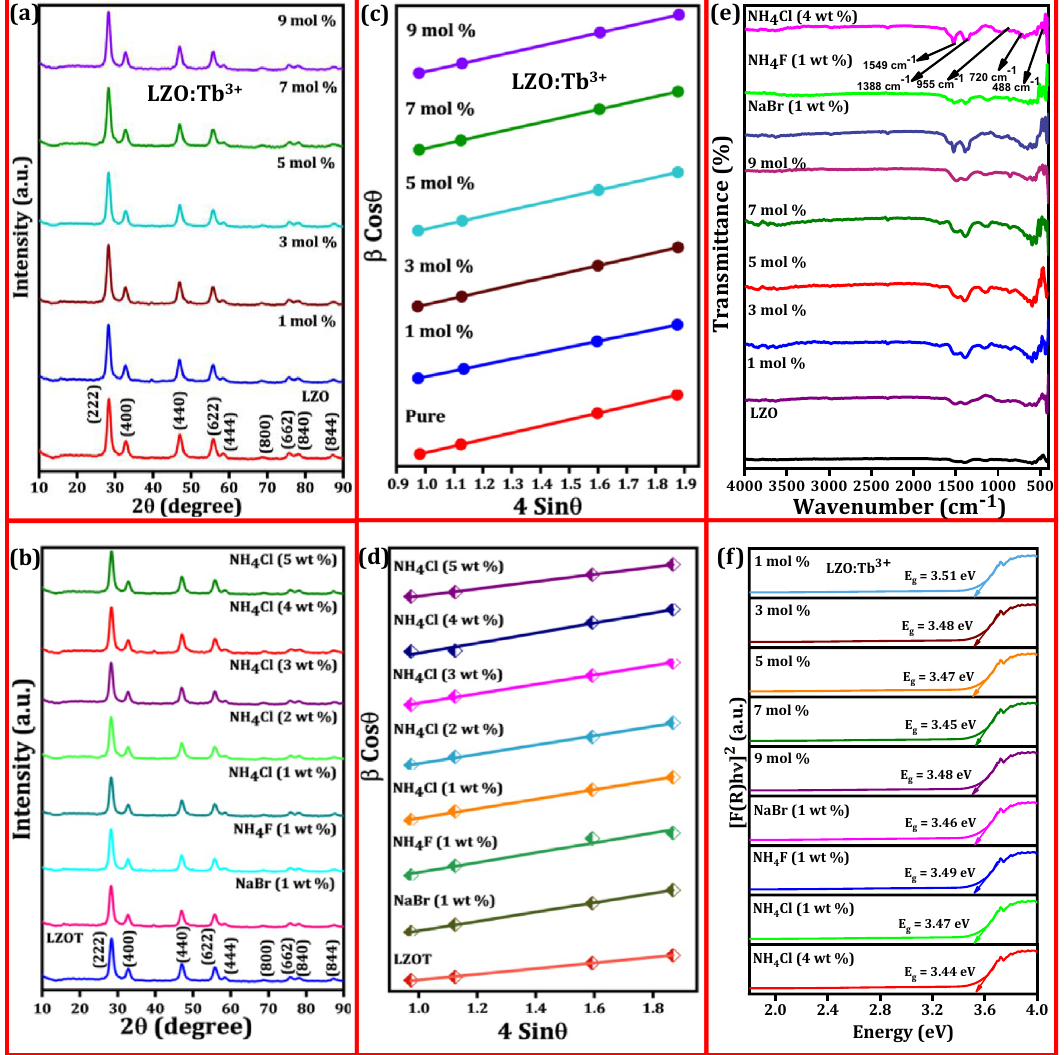
Figure 1. ( a ) PXRD profiles of prepared LZO sample and Tb 3+ (1–9 mol %) doped LZO NPs calcined at ~ 800 °C for ~ 3 h; ( b ) PXRD profiles of LZOT NPs and various fluxes (NaBr, NH 4 F and NH 4 Cl) conjugated LZOT NPs; ( c , d ) W–H plots of the corresponding samples of ( a ) and ( b ); ( e ) FT-IR spectra of the LZO, LZO:Tb 3+ (1–9 mol %) NPs and LZOT: NaBr, NH 4 F (1 wt. %), NH 4 Cl (4 wt. %) NPs; ( f ) Energy band gap plots of the LZO:Tb 3+ (1–9 mol %) NPs and fluxes assisted LZOT NPs estimated using K-M